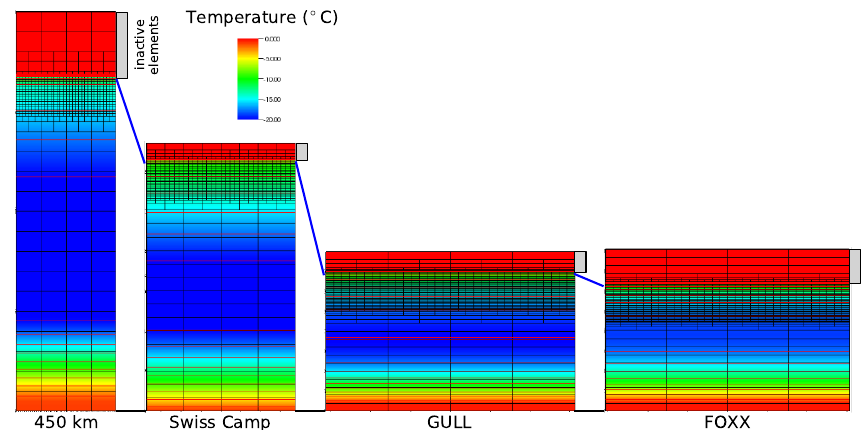
Figure 4. The gradual deformation of the computing mesh along the flow line to accommodate for the varying ice thickness. The ice surface is marked with blue lines between meshes, and inactive elements are indicated with gray bars (red elements on top). The precise position of the surface with respect to the mesh is tracked with adaptive mesh refinement. Modeled ice temperatures are indicated with colors. The greenish elements close to the surface are accumulated during flow (thickest at Swiss Camp at the equilibrium line) and slowly removed from the top due to ablation (sites GULL and FOXX). Note that computational mesh shown is for illustration only, actual model runs were performed on considerably finer